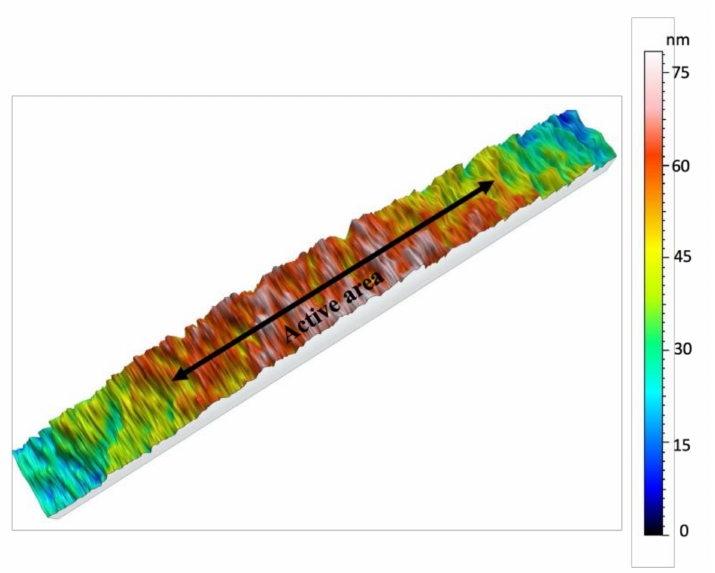
Figure 3. Surface roughness of the metalized electrode and P(VDF-TrFE) area of the fabricated transducer. Scan area- 90 × 600 µ m 2 . Active area indicated in the figure refer to the metalized electrode